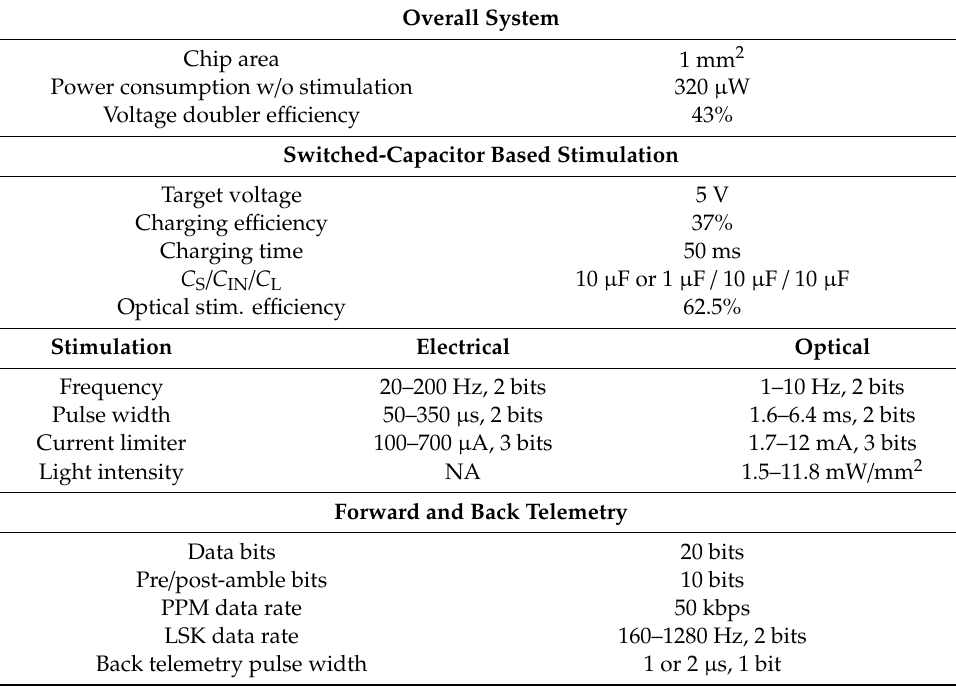
Figure 12. Power consumption of each block in the FF-WIOS2 device when applying ( a ) electrical stimulation and ( b ) optical stimulation. Table 1. FF-WIOS2 SoC Measured Specifications.